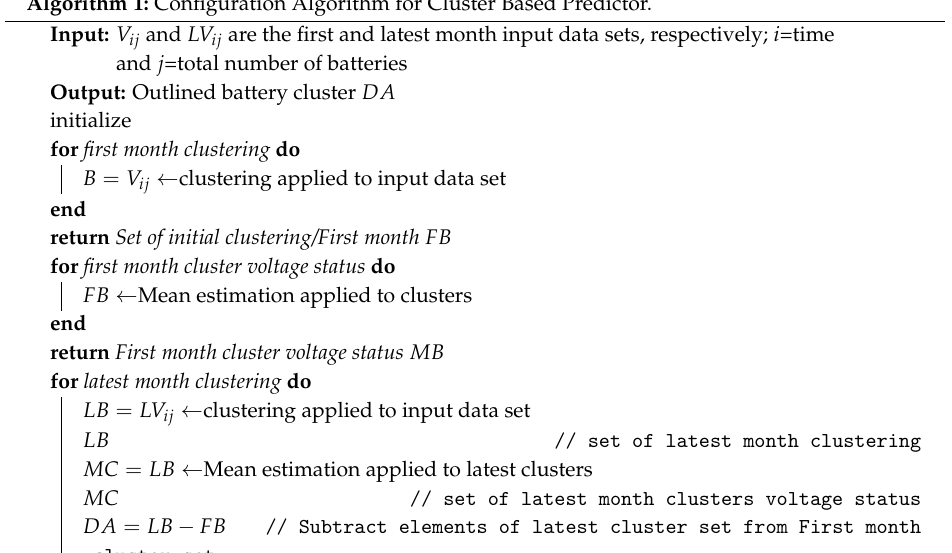
Algorithm 1: Configuration Algorithm for Cluster Based